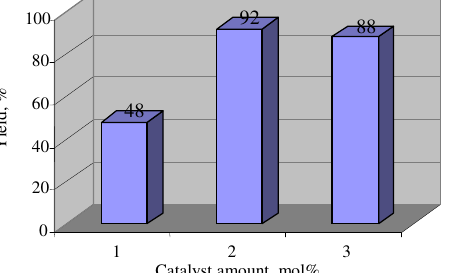
Figure 1. The result of using different amounts of H N -[(4-methoxyphenyl)-(2-hydroxy-naphthalen-1-yl)-methyl]-acetamide under solvent-free